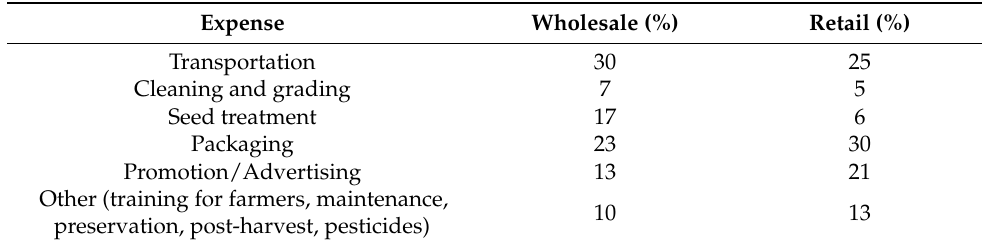
Table 2. Additional expenses after buying seeds.